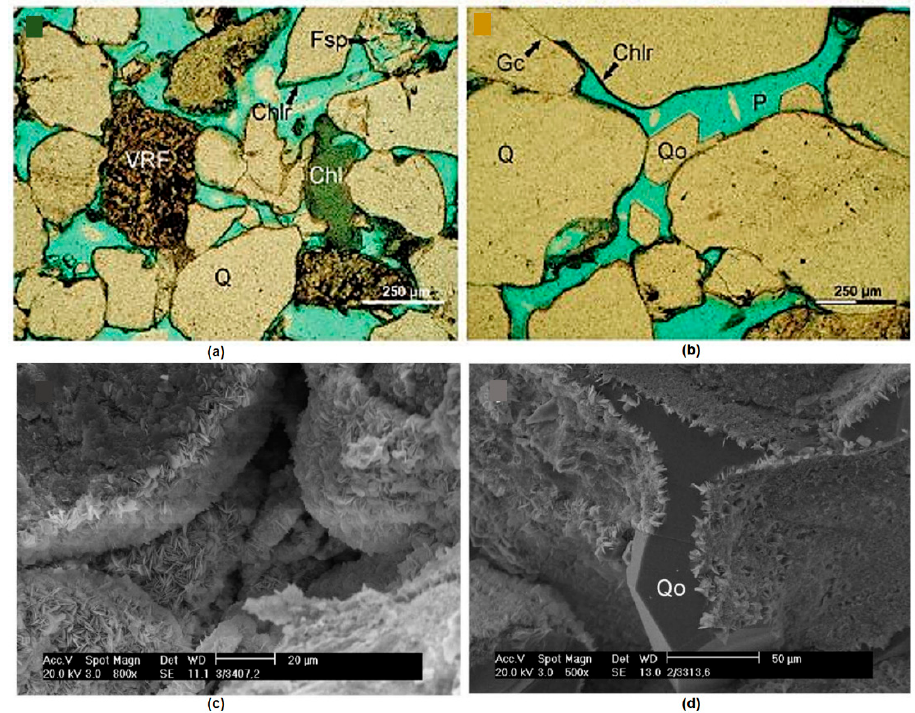
Figure 5. Thin sections ( a , b ) and SEM images ( c , d ) of the C-sand interval demonstrate the depositional and diagenetic characteristics, where Chl = chlorite, Chlr = chlorite rim, Q = quartz, Fsp = dissolving of feldspar grains, VRF = alteration of volcanic rock fragments, Qo = Idiomorphic quartz outgrowths filling partially the pores after Chlr, Gc = Grain contact. P = porosity is 15.3 to 22% in wells C and D [24].